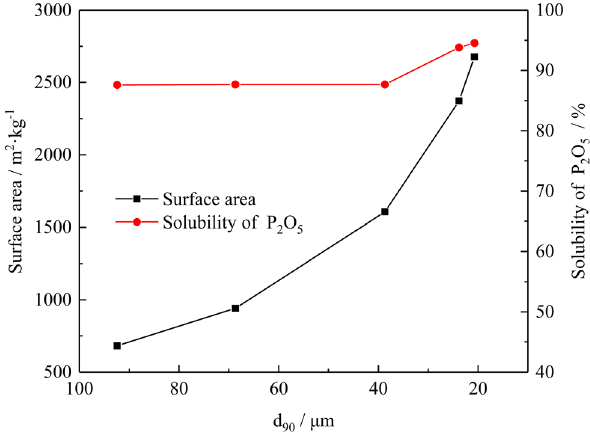
Figure 8: E ff ect of particle size on the P 2 O 5 solubility of the high - P - containing